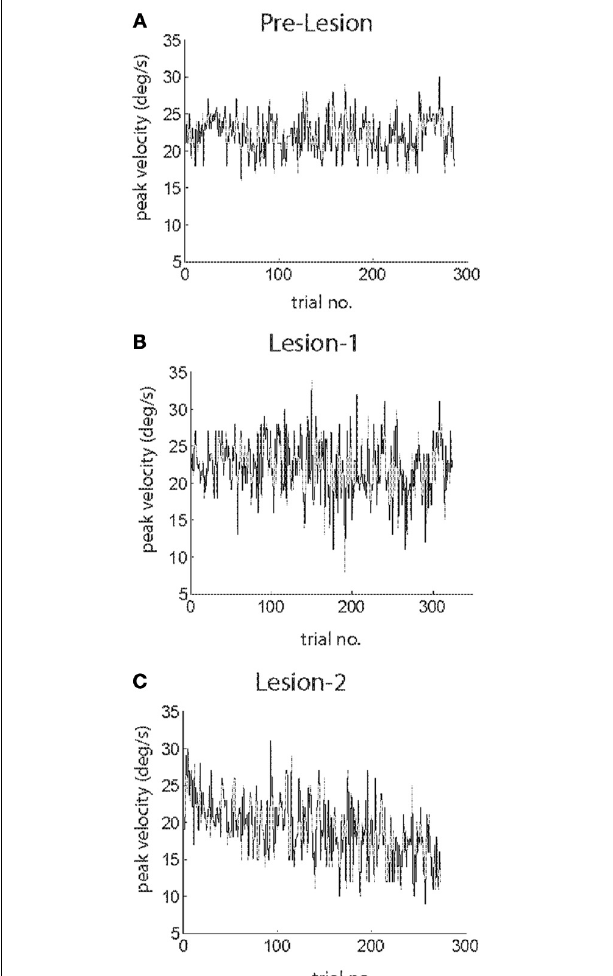
FIGURE 5 | Plots of peak eye velocity as function of trial number for exemplary sessions of SPEM resilience before the lesion (A), after L1 (B) and after L2 (C). Note that eye velocity declines with increasing trial number after